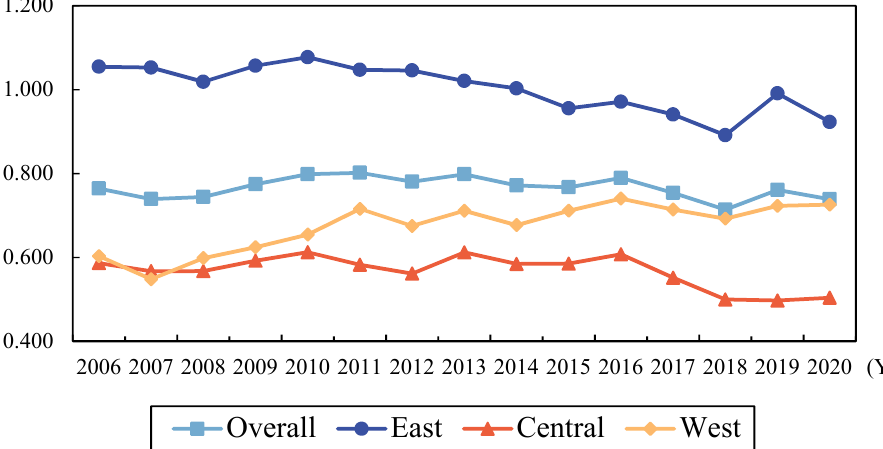
Figure 2. Year-to-year changes in livelihood resilience of rural residents by region in China. Source: the authors’ own work.